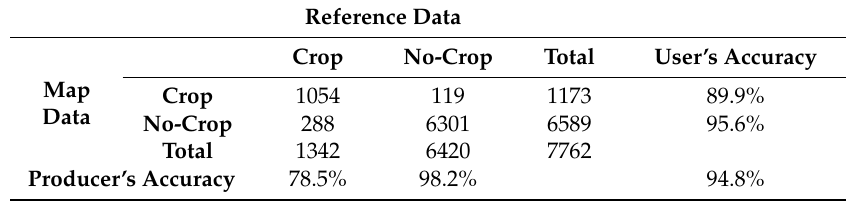
Table 10. The error matrix showing the overall accuracy of the GFSAD250m cropland extent map.